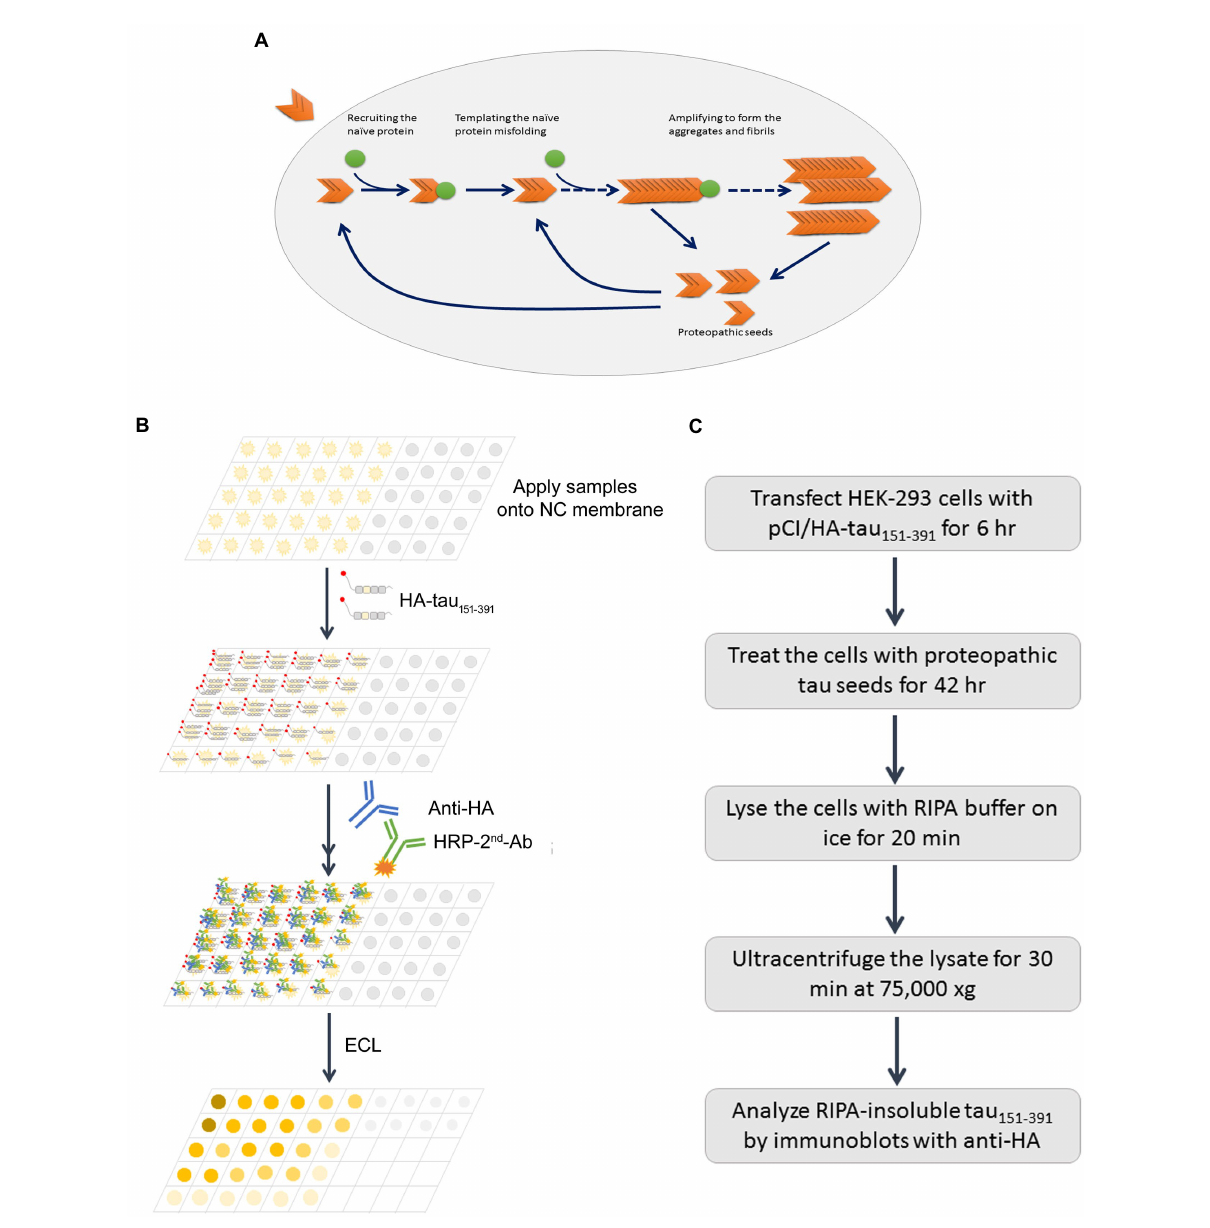
FIGURE 8 Schematic diagrams of proteopathic tau templated tau aggregation, capture assay, and seeded tau aggregation assay. Misfolded proteopathic tau enters neurons, recruits monomeric/naïve tau and templates its misfolding and aggregation (A) . The tau capture assay in vitro is based on the capability of preoteopathic tau to recruit naïve tau (B) , while the seeded tau aggregation assesses the whole process (C)